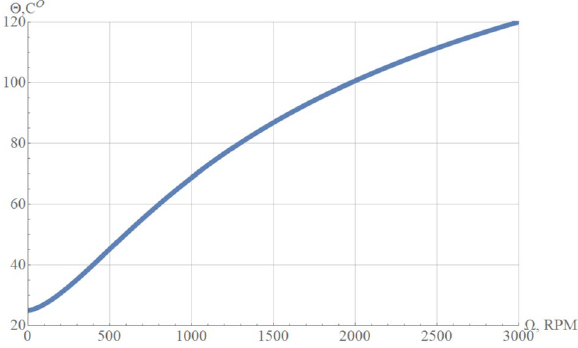
Fig. 3 Coupling surface temperature